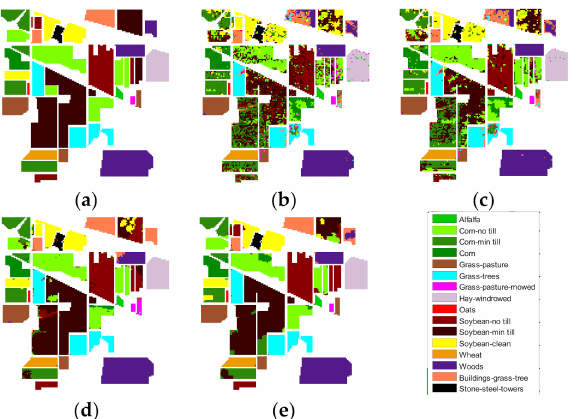
Figure 10. Classification results of different features on Indian Pines data: ( a ) label data, ( b ) prediction image of true spectral data, ( c ) prediction image of MSFF data, ( d ) prediction image of augmented data, and ( e ) prediction image of data combining data augmentation and MSFF.